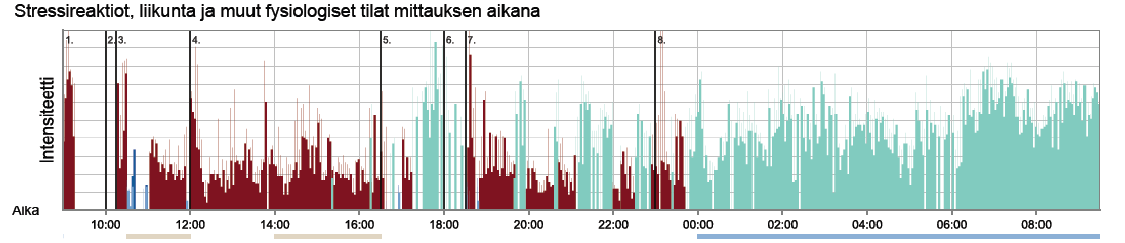
Figure 1. Firstbeat report used in data